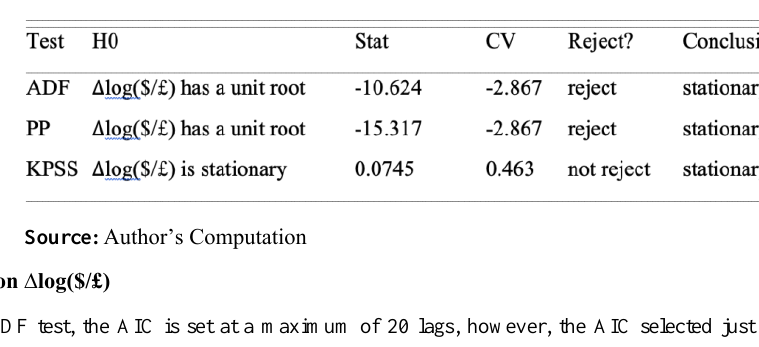
Table 3: Unit root/stationarity tests on ∆